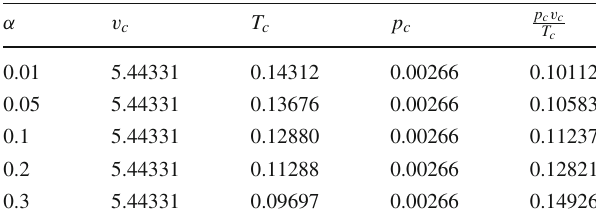
Table 2 Behaviour of the critical parameters v c , T c , p c e p c v c different values of α and for Q = 1, a = 0 . 1 and ω q = − 2 / 3